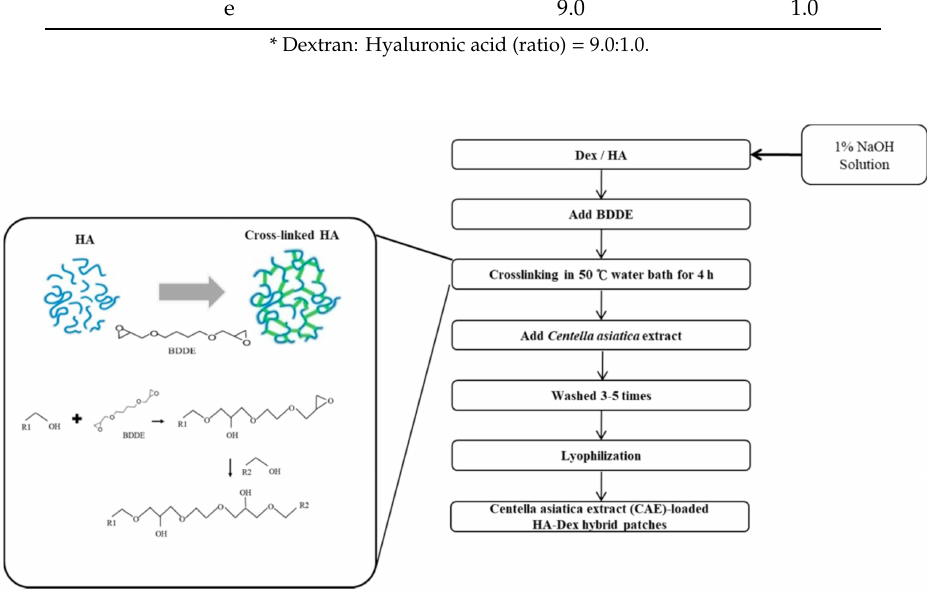
Figure 2. Schematic diagram showing the fabrication process of Centella asiatica extract (CAE)-loaded HA-Dex hybrid patches. Dextran (Dex, R1); hyaluronic acid (HA,